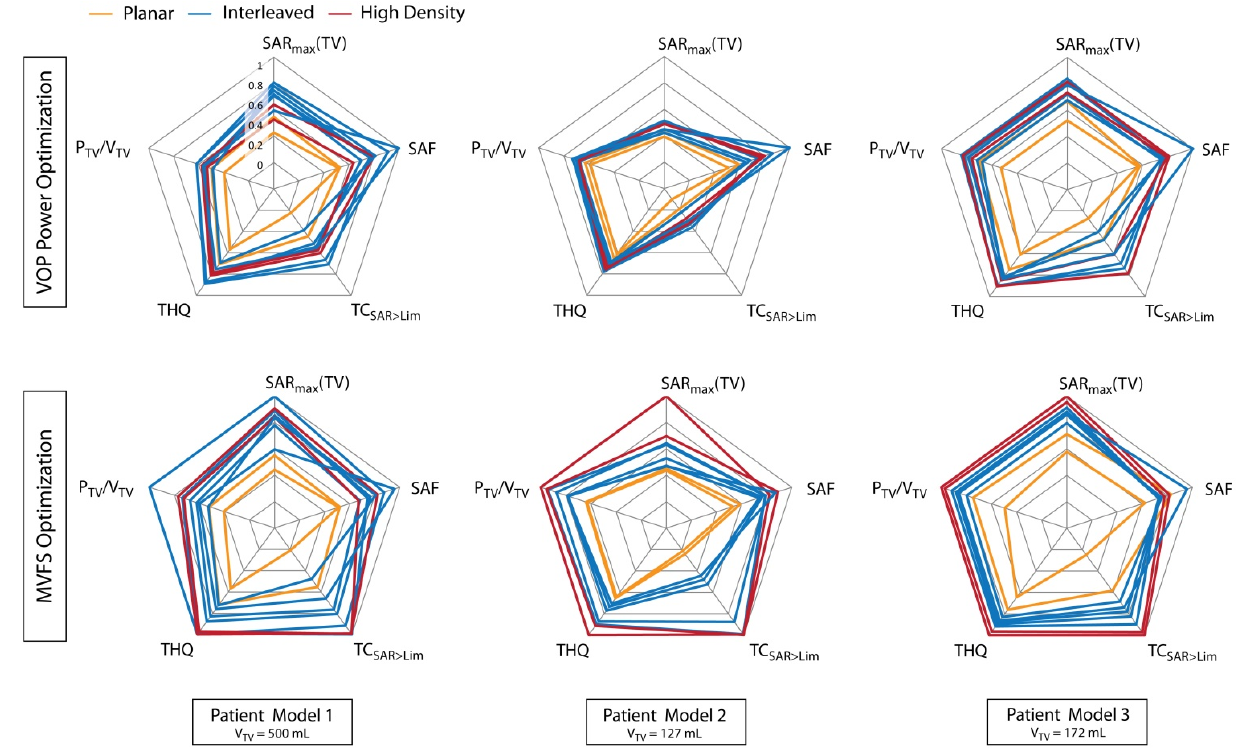
Figure 5. Influence of the number of independent transmit channels and their arrangement on the TIP results, comparing the VOP power optimization and the MVFS optimization. For better comparability, all metrics have been normalized to their inter-algorithm, inter-array maximum. Orange: planar arrays, *.P.*; blue: interleaved arrays, 16.I.* and 16.2R.*; red: high density arrays 32.2R.*.